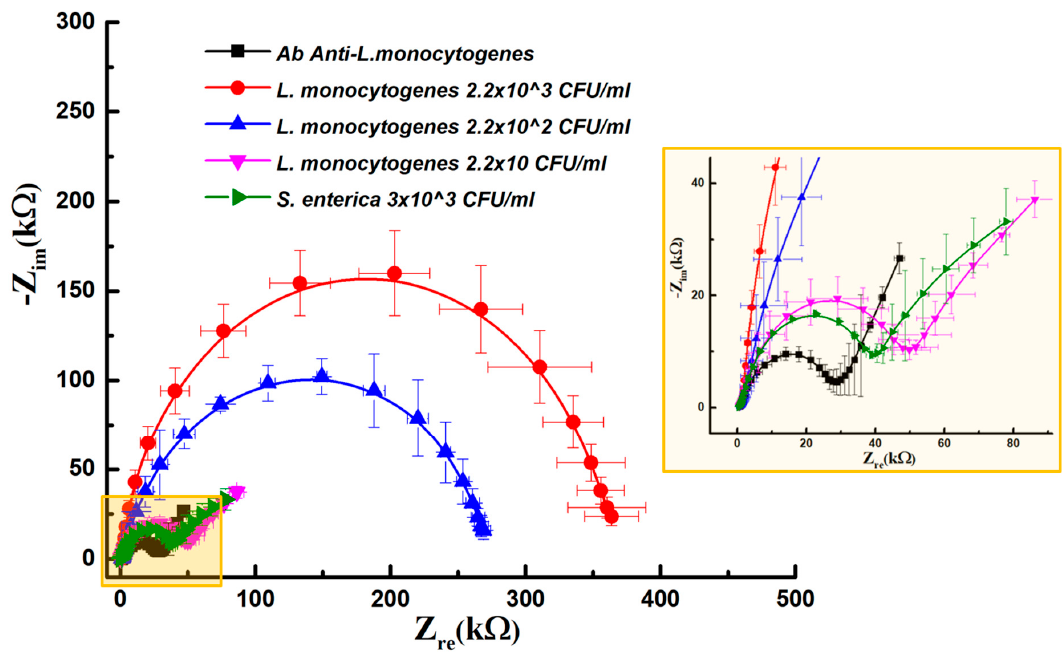
Figure 3. Nyquist plots related to the incubation of different concentrations of Listeria monocytogenes on the sensing layer with antibodies against the bacterium. The higher the concentration used, the largest is the diameter of the curve. In the case of unspecific incubation of the sensing layer with Salmonella enterica (green line) a slight increase in impedance, compared with antibody layer, was observed.